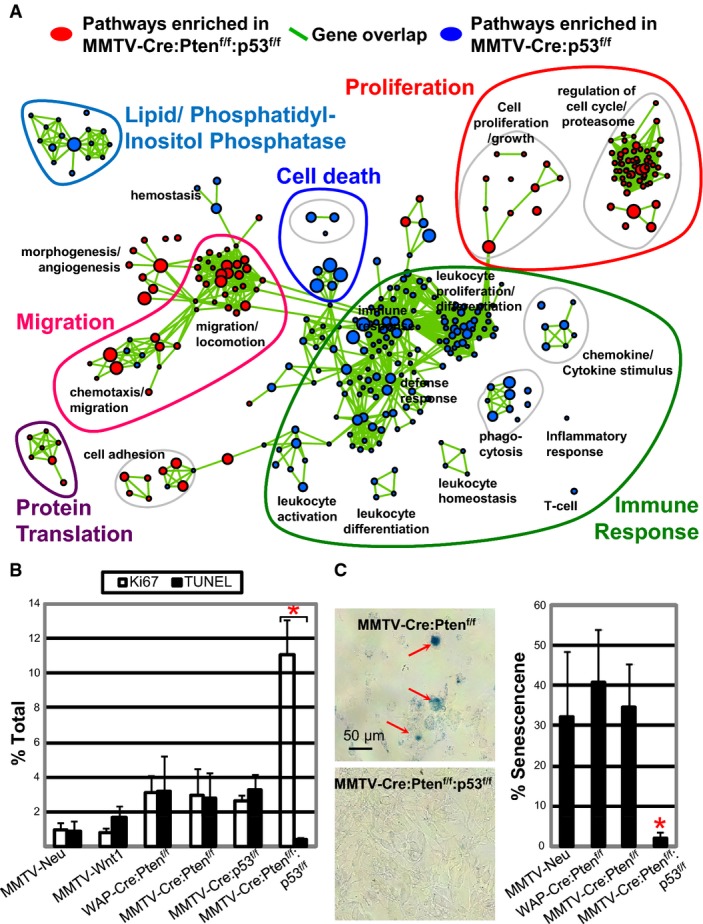
Pathway analysis of Pten/p53- versus p53-deficient claudin-low-like TNBCGSEA analysis showing selected pathways enriched in claudin-low-like
MMTV-Cre:Ptenf/f:p53f/f (red) versus pathways enriched in
MMTV-Cre:p53f/f (blue) tumors. Green lines connect overlapping pathways. Proliferation,
cell death, immune response, protein translation, and PI phosphatase pathways are highlighted;
corresponding genes listed in Supplementary Table S1H–M. Full pathway analysis is shown in
Supplementary Fig S5A.Cell proliferation (Ki67) and apoptosis (TUNEL) in indicated tumors. Representative staining and
statistical analysis are shown in Supplementary Fig S5D and E.Senescence-associated β-Gal staining of indicated primary tumor cells plated on
collagen-coated coverslips showing significantly lower level of senescence in
MMTV-Cre:Ptenf/f:p53f/f tumor cells. Data information: *Significant difference comparing
MMTV-Cre:Ptenf/f:p53f/f with MMTV-Neu,
P = 0.012 (ANOVA with Tukey test for post
hoc). Comparisons with other tumor models gave lower P-values.